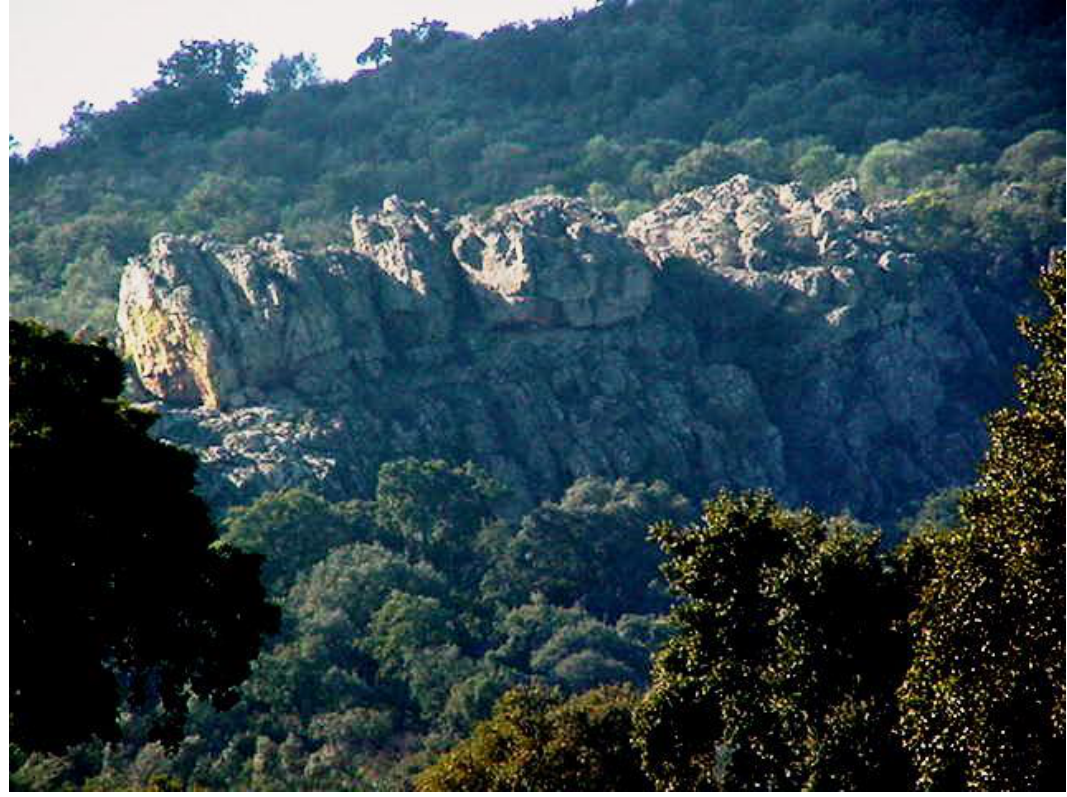
Figure 1. Overview of the crest where the group is located in sheltered